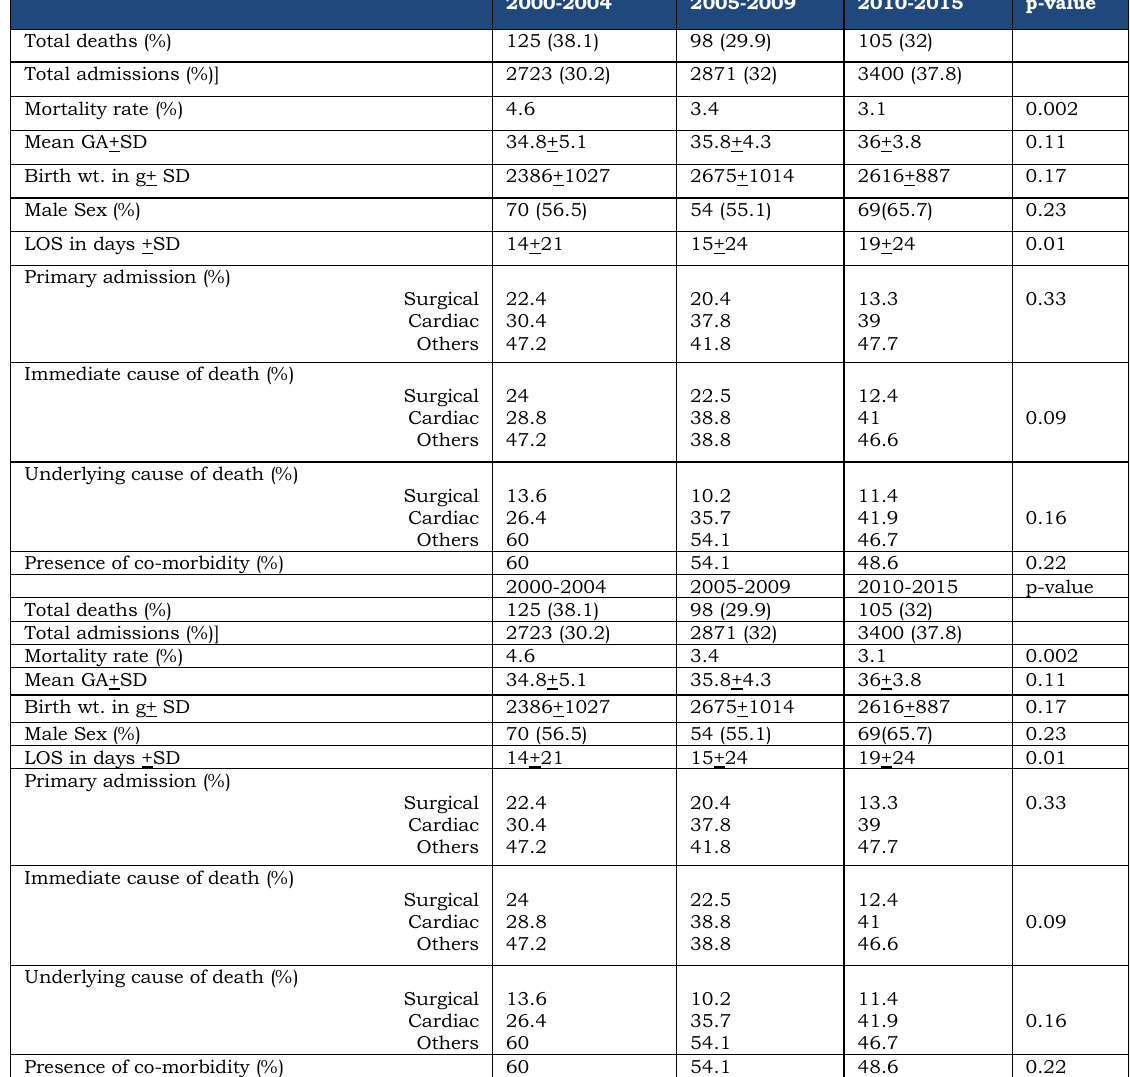
Table 2- Mortality pattern across three